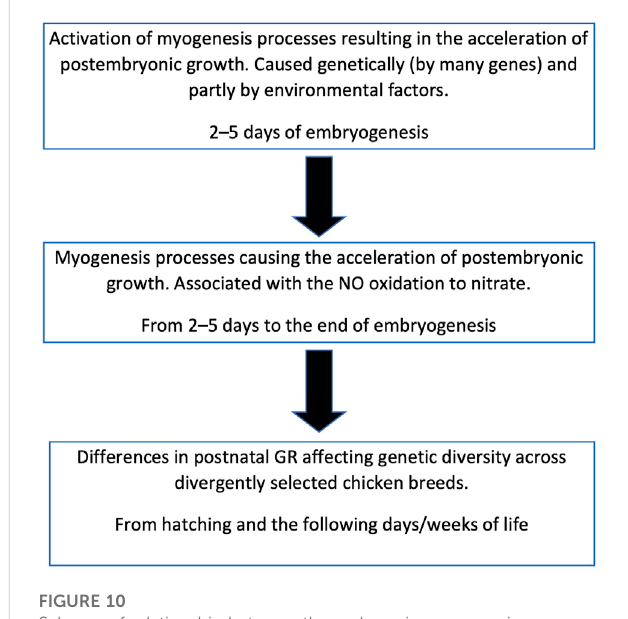
FIGURE 10 Scheme of relationship between the embryonic myogenesis processes, postnatal growth and genetic diversity in chicken